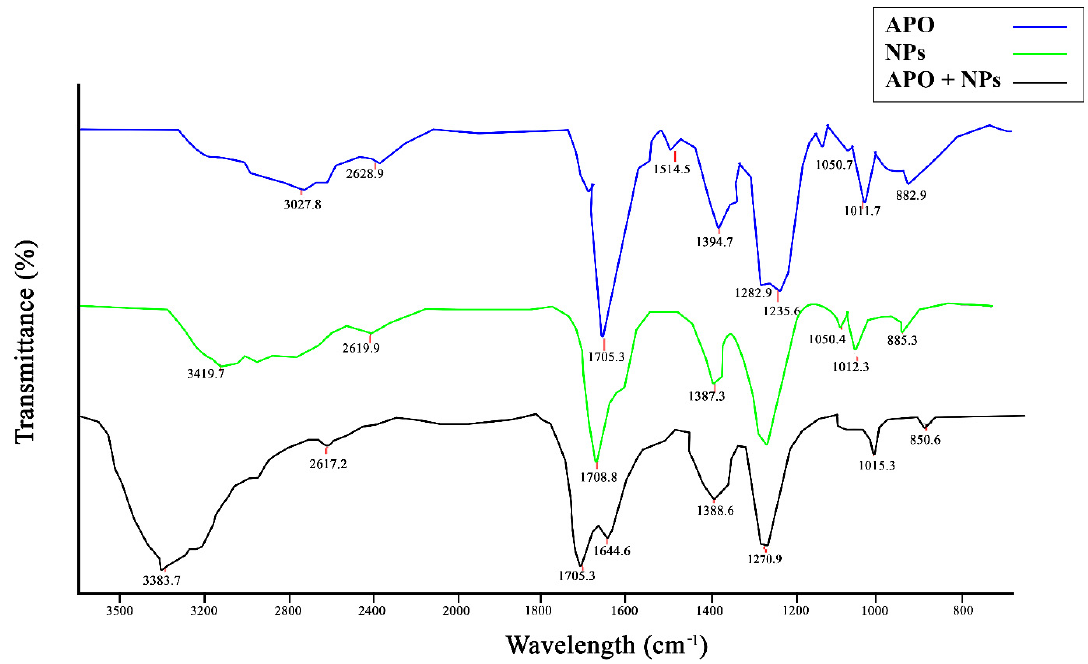
Figure 3. FTIR analysis graph scan of APO, NPs, and APO-NPs, respectively, from 400–4000 cm − 1